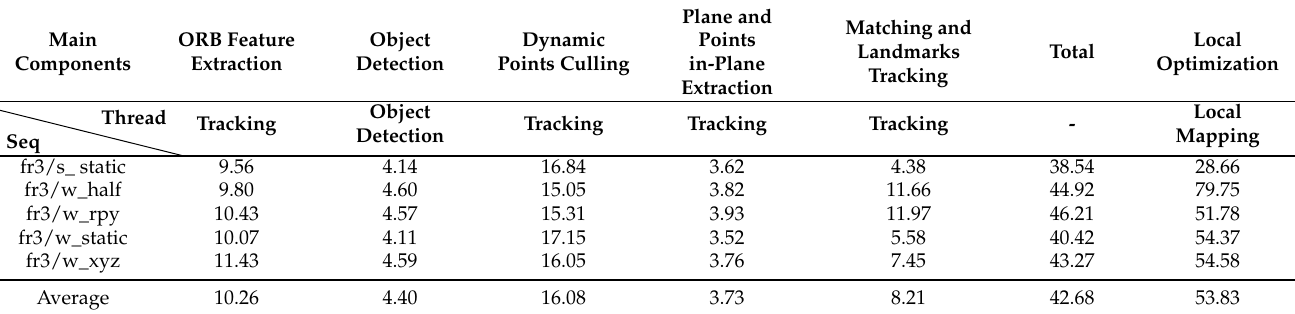
Table 5. Average operating time of principal components